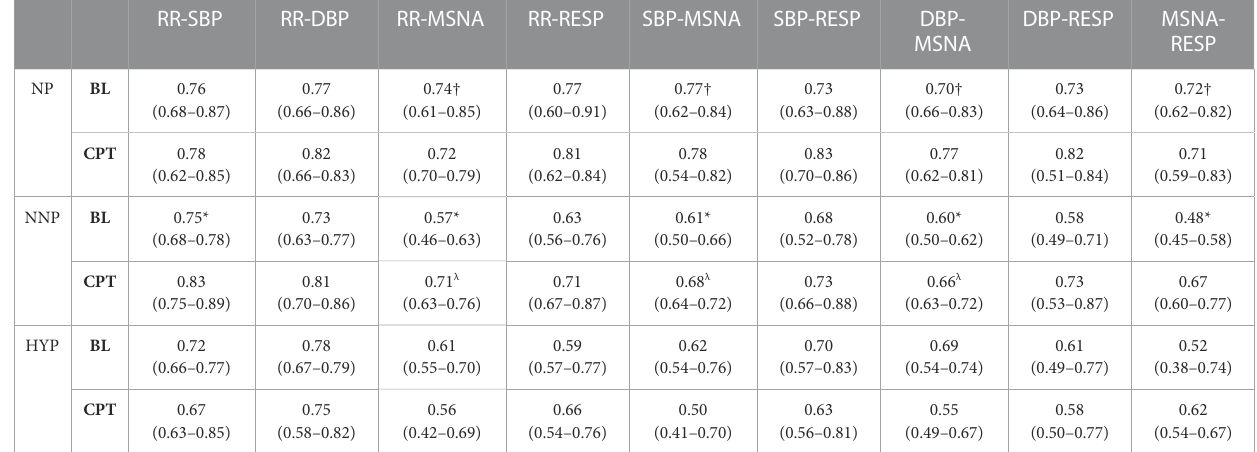
TABLE 2 Wavelet phase coherence results in the high-frequency band. The table shows the results for normotensive non-pregnant women (NNP), normotensive pregnant women (NP), and hypertensive pregnant women (HYP) during baseline (BL) and cold pressor test (CPT) in terms of median and 95% CI. RR: RR interval. DBP:Diastolicbloodpressure.SBP:Systolicbloodpressure.MSNA:Musclesympatheticnerveactivity.RESP:Respiratorywave.*:signi fi cantdifferencewithCPT. † : signi fi cant difference with NNP. λ : Signi fi cant difference with HYP.